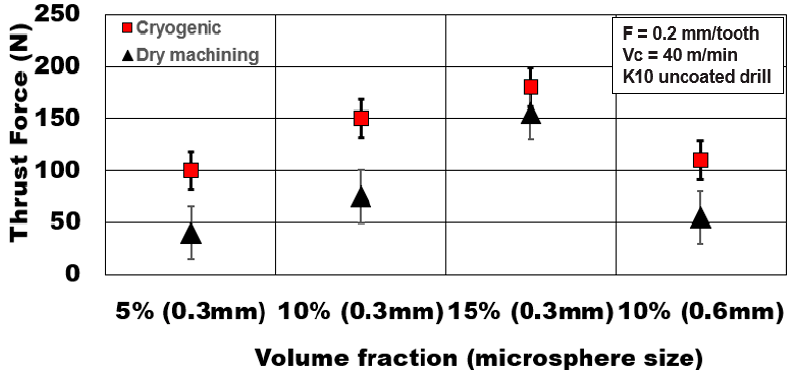
Figure 4. Effect of hollow microsphere volume fraction and average size on thrust force during plunge drilling of AZ31-alumina syntactic foam.